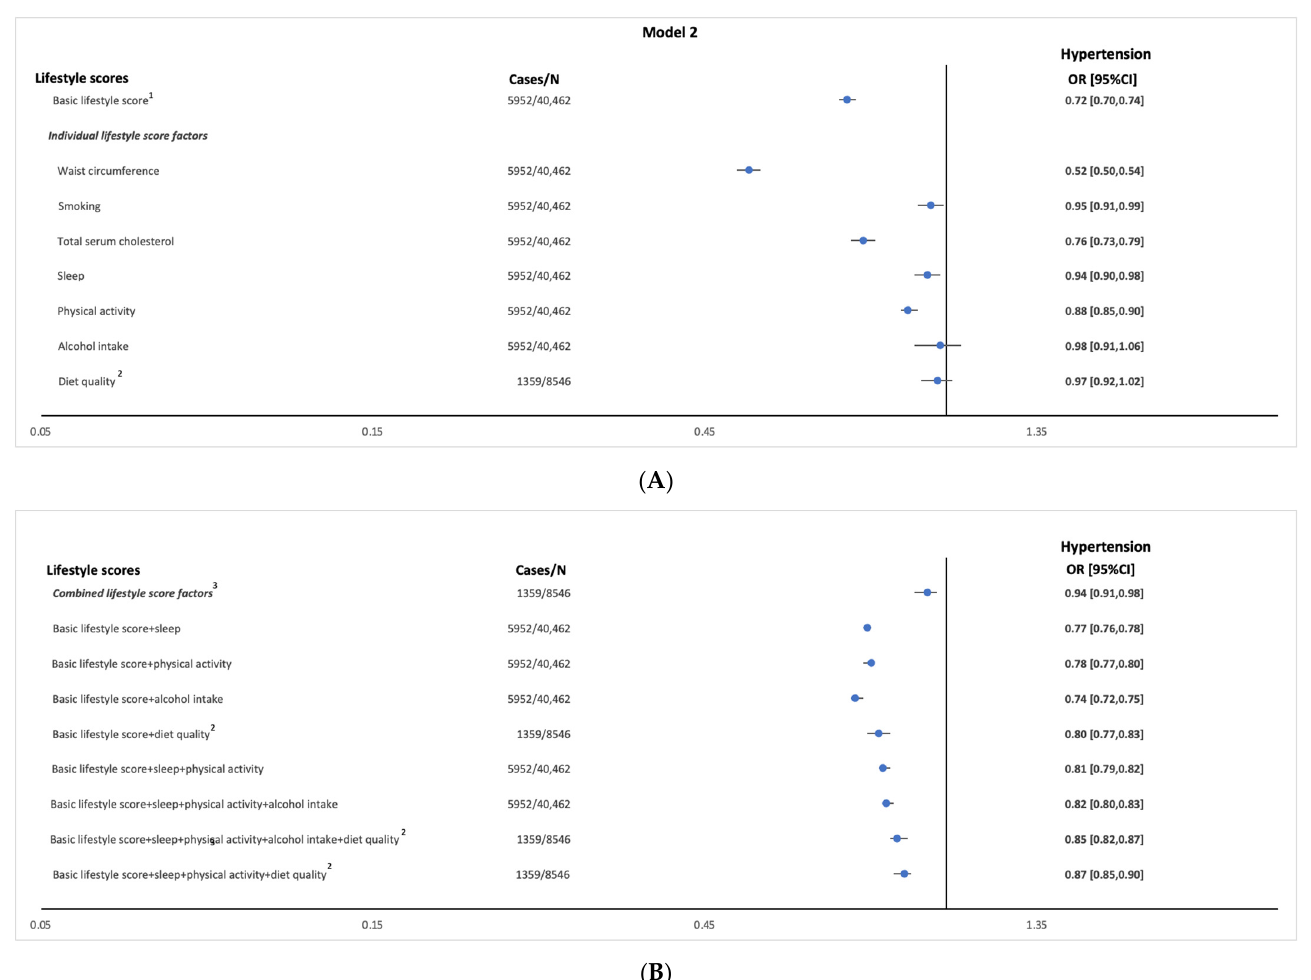
Figure 1. Odds ratio [95%CI confidence intervals] of hypertension per 1-point increase in total ( A ) basic, individual, and ( B ) combined lifestyle score factors in a sample of the Airwave Health Monitor- ing Study ( n = 40,462). Model 1 is adjusted for age, sex, and employment country. Model 2 is model 1 adjusted for marital status, education, ethnicity, annual household income, and history of chronic diseases. Hypertension was defined as having SBP ≥ 140 mmHg or DBP ≥ 90 mmHg, reported diagnosis or on anti-hypertensive medication 1 Basic lifestyle score includes (waist-circumference + smoking + cholesterol) 2 Analyzed in a subsample of n = 8546 3 . Combined lifestyle score factors include (sleep + physical activity + alcohol intake + diet quality). Across levels of the basic lifestyle-score, the odds of having hypertension decreased with scoring higher for the basic lifestyle-score, with ORs being 0.49 (95% CI: 0.46, 0.54) for intermediate level and 0.34 (95% CI: 0.32, 0.37) for the ideal level compared with the poor level (Model 2, Figure 2A and Table S1). Age-stratified multivariate regression analysis showed that the association between the basic lifestyle-score and BP was stronger in the older age groups (40 to ≤ 50 and >50 years), (SBP: − 2.46 (95%CI: − 2.62, − 2.29); DBP: − 2.25 (95%CI: − 2.36, − 2.14)) and (SBP: − 2.34 (95%CI: − 2.70, − 1.98); DBP: − 1.72 (95%CI: − 1.93, − 1.52)) compared to the younger age groups (Table